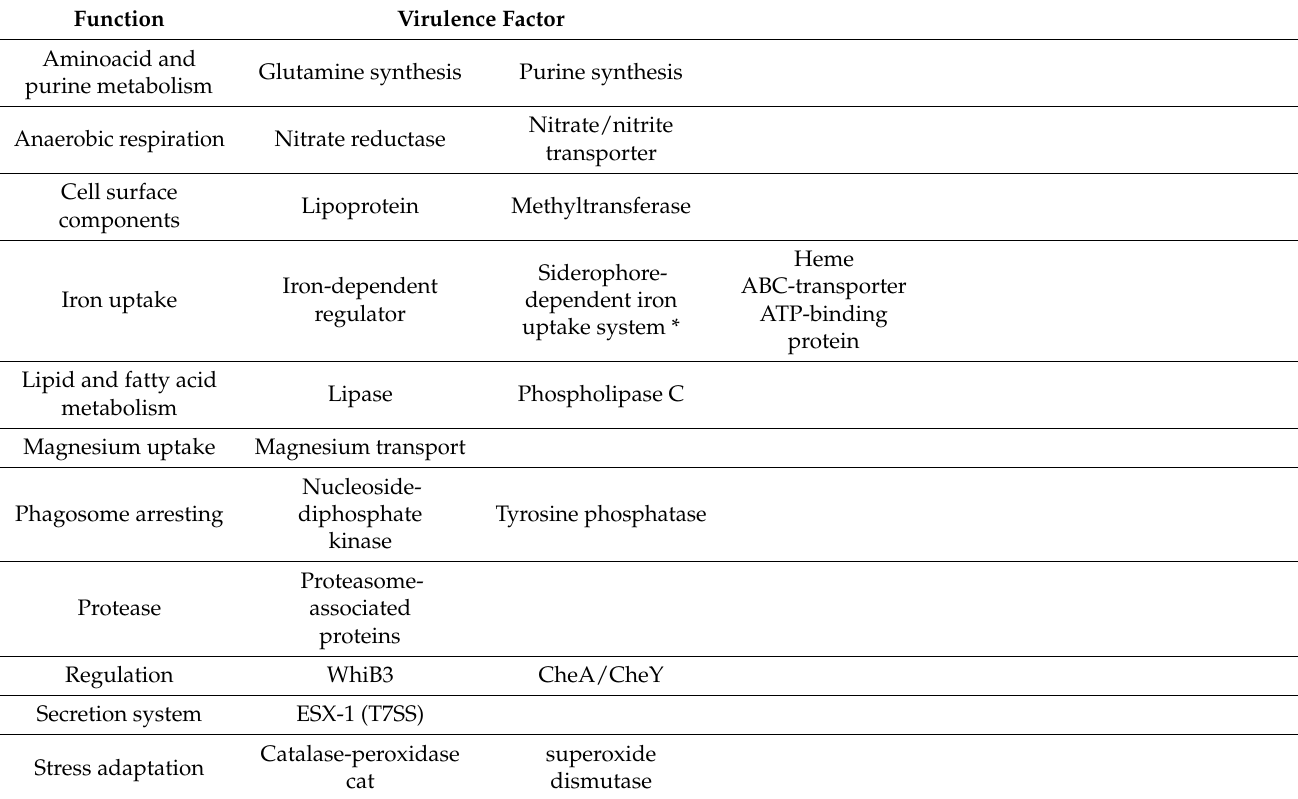
Table 1. The virulence factors found in the pan genome of A. phocae